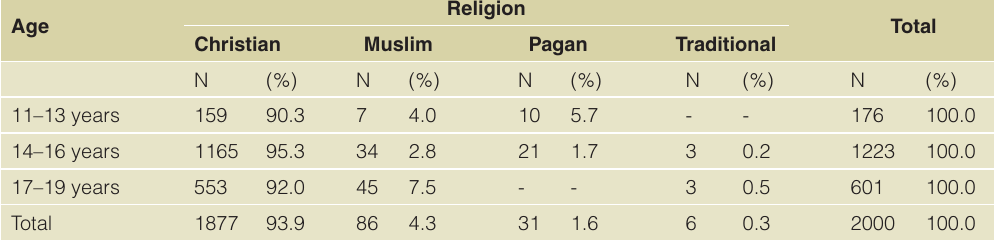
Table 6. Descriptive analysis of age and religion distribution.